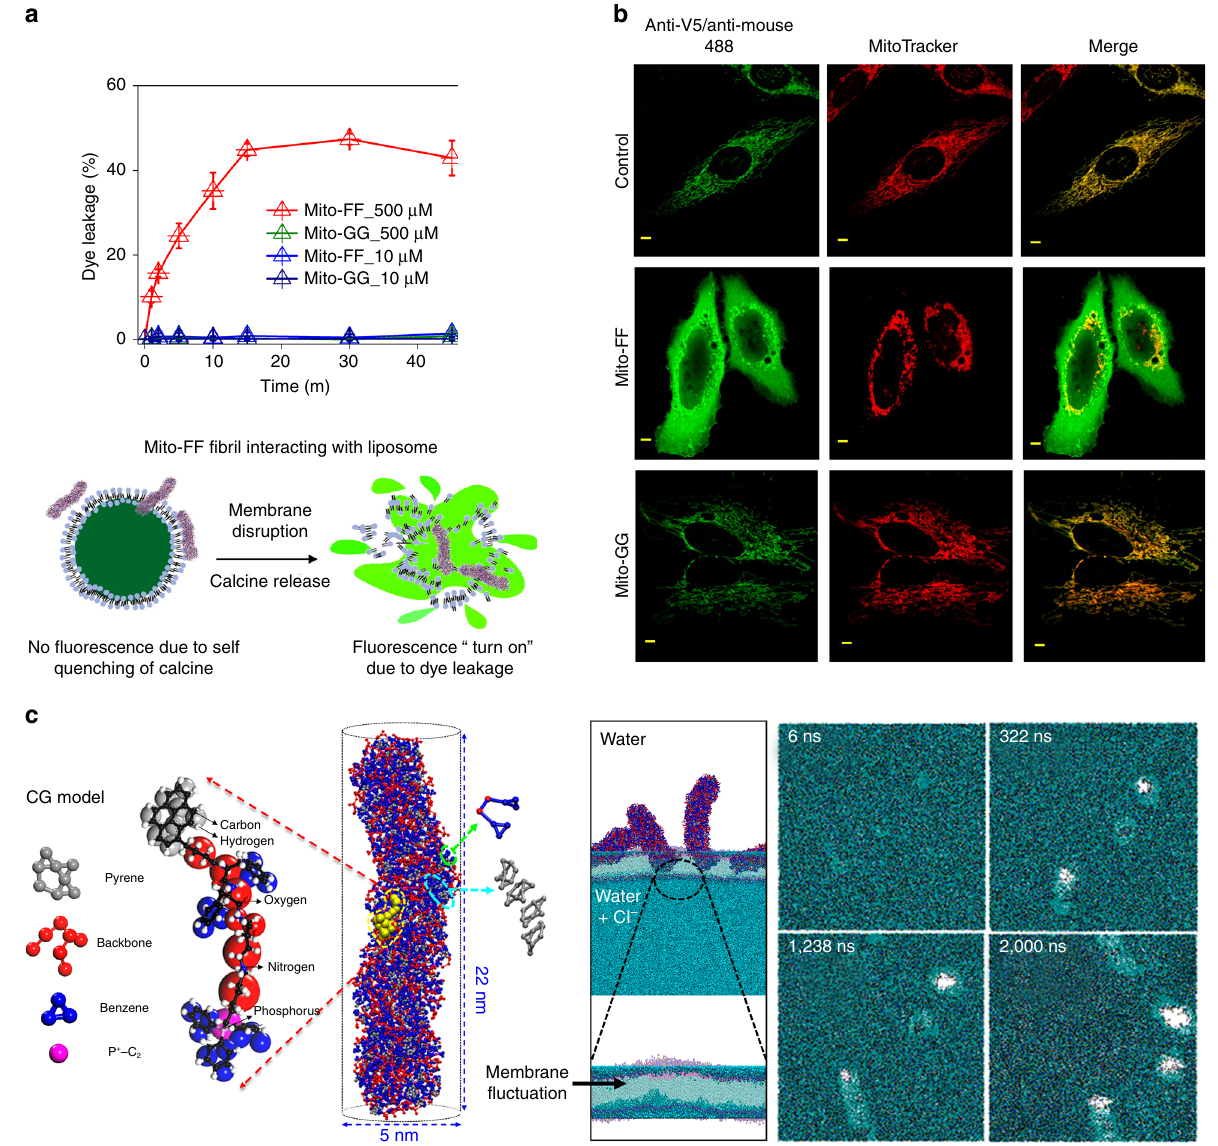
Fig. 5 Membrane disruption induced by Mito-FF. a Membrane disruption ability of Mito-FF fi brils monitored using calcein encapsulated in a model liposome; a schematic diagram is provided. Data represent mean ± s.d. from three independent experiments. b Leakage of mitochondrial protein to the cytosol monitored using APEX labeling (scale bar, 2 μ m). c Molecular simulation results of Mito-FF fi brils with coarse-grained (CG) model and analysis of their membrane penetration ability over time. Details of simulation method are introduced in the Supplementary electron microscope imaging experiments 25 . In our assay, we employed V5 epitope-tagged APEX2 (i.e., Mito-V5-APEX2) for immuno fl uorescence imaging of APEX2 with an anti-V5 anti- body. We expect that the localization pattern of Mito-V5-APEX2 compromise the integrity of the inner mitochondrial membrane